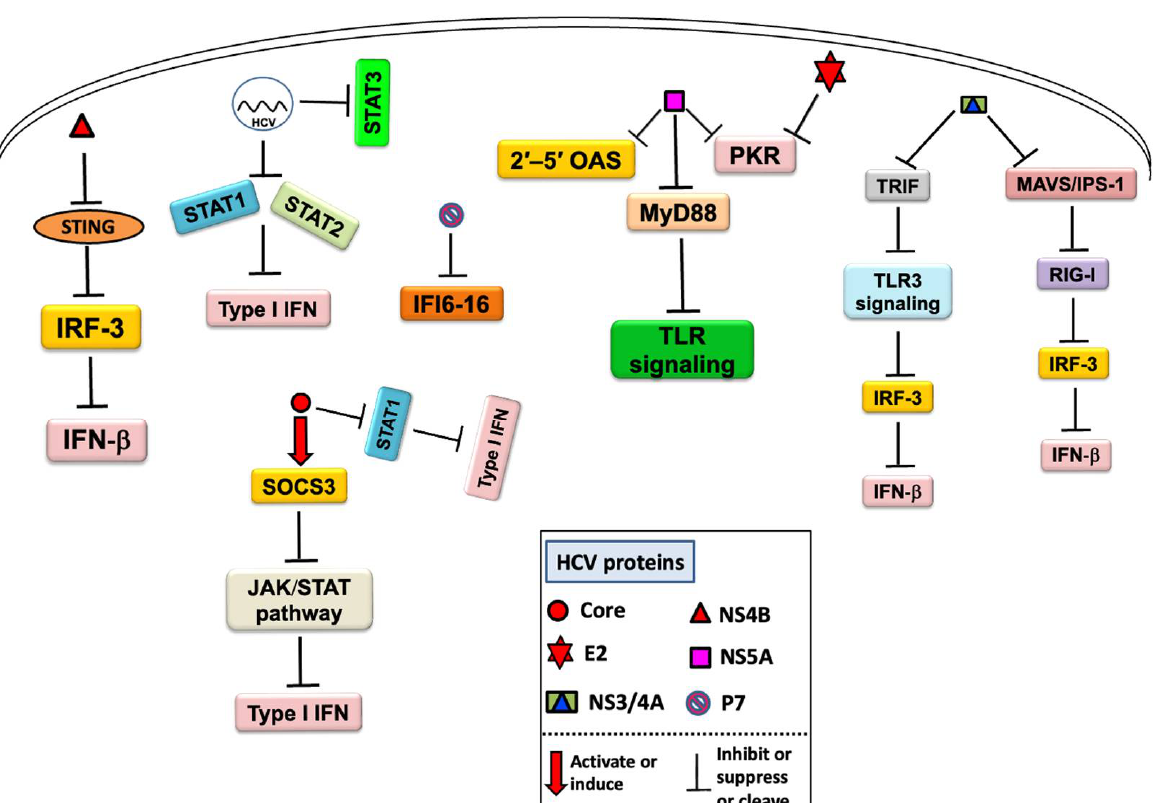
Figure 2. An overview of the mechanism of the host innate immune response inhibition by HCV and its proteins.